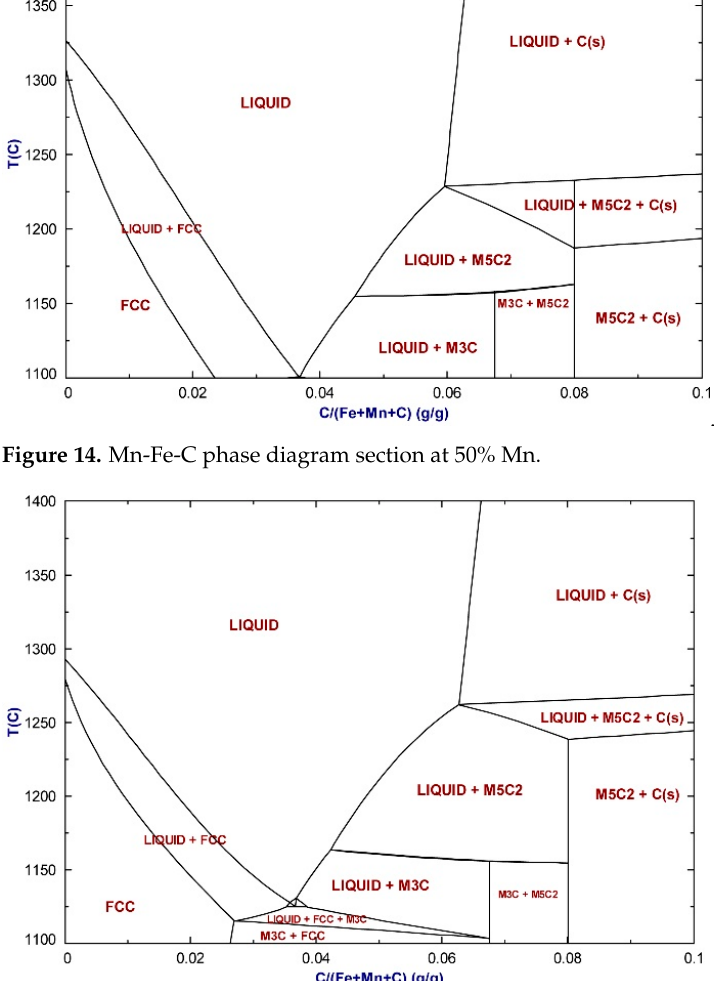
Figure 15. Mn-Fe-C phase diagram section at 60% Mn.